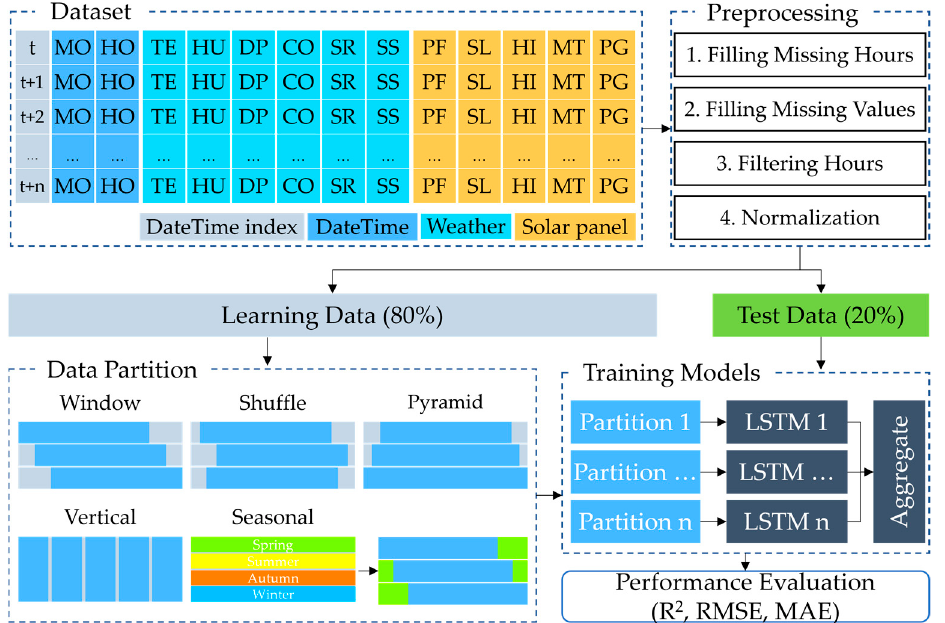
Figure 1. Overall flow of the proposed methodology. Here, the abbreviations of the features are described in Table 2; R 2 : Coefficient of Determination; RMSE: Root Mean Squared Error; MAE: Mean Absolute Error.